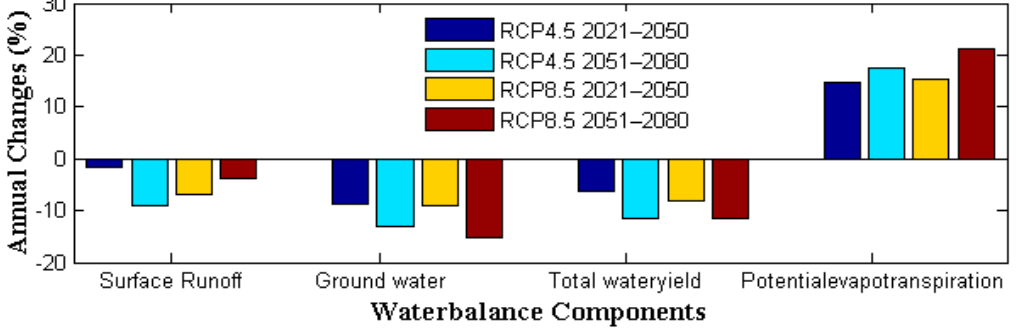
Figure 12. Annual water balance components under the combined land use and climate change.